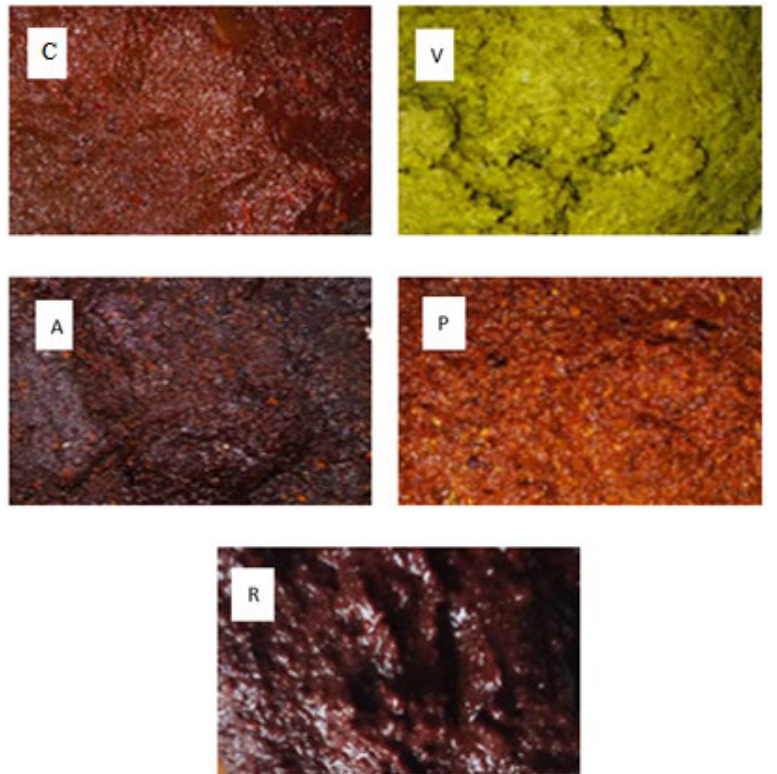
Figure 1. The physical state of the five mole samples from the State of Hidalgo in Mexico. They were selected according to different colorations and formulations: casero ( C ), verde ( V ), almendrado ( A ), pipian ( P ), and ranchero ( R ).